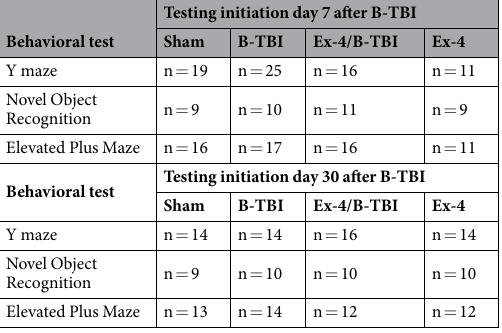
Table 1. Pre-injury animal treatment groups. The animal numbers were as follows when Ex-4 was administered prior to the blast